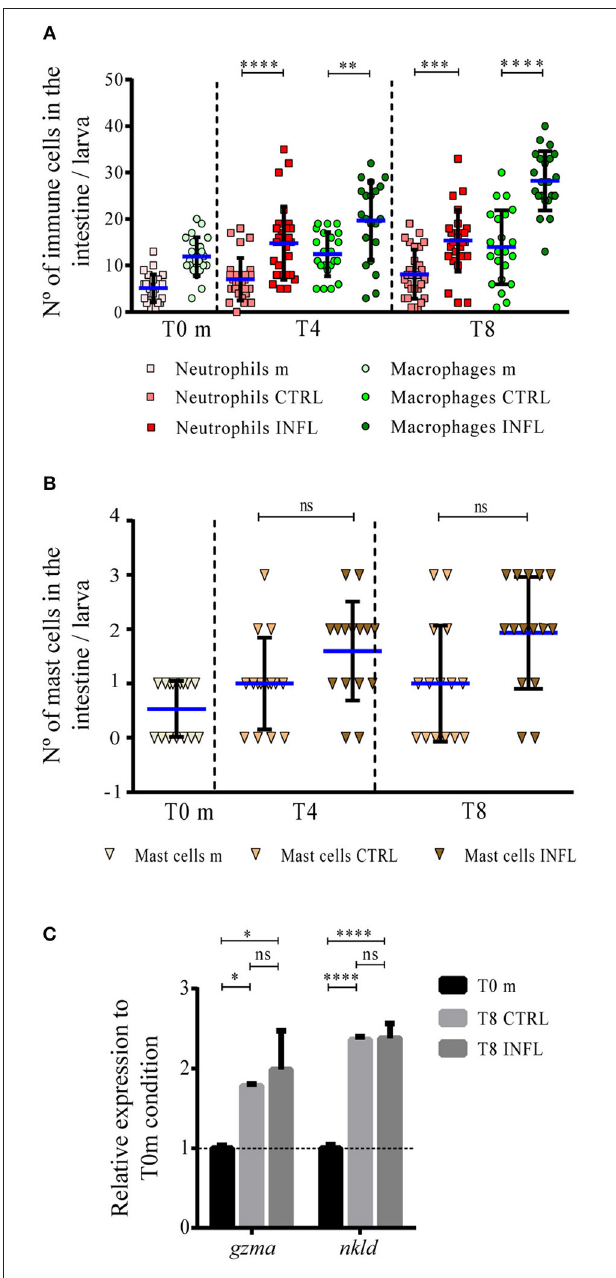
FIGURE 2 | Neutrophils and macrophages increase in number in the gut during the inflammation process triggered in the developed feeding model. The number of neutrophils/macrophages (A) , and mast cells (B) was quantified under the different conditions (m, maintenance; CTRL, control; INFL, inflammation) and time points (T0m: 18 dpf; T4: 21 dpf; T8: 25 dpf). (C) Relative mRNA levels of gzma and nkld were analyzed. Data were normalized against rpl13a and compared to T0 maintenance condition (dotted line). ** p < 0.01; *** p < 0.001; **** p < 0.0001. Experiments were done at least in three biological replicates with 20 individuals per